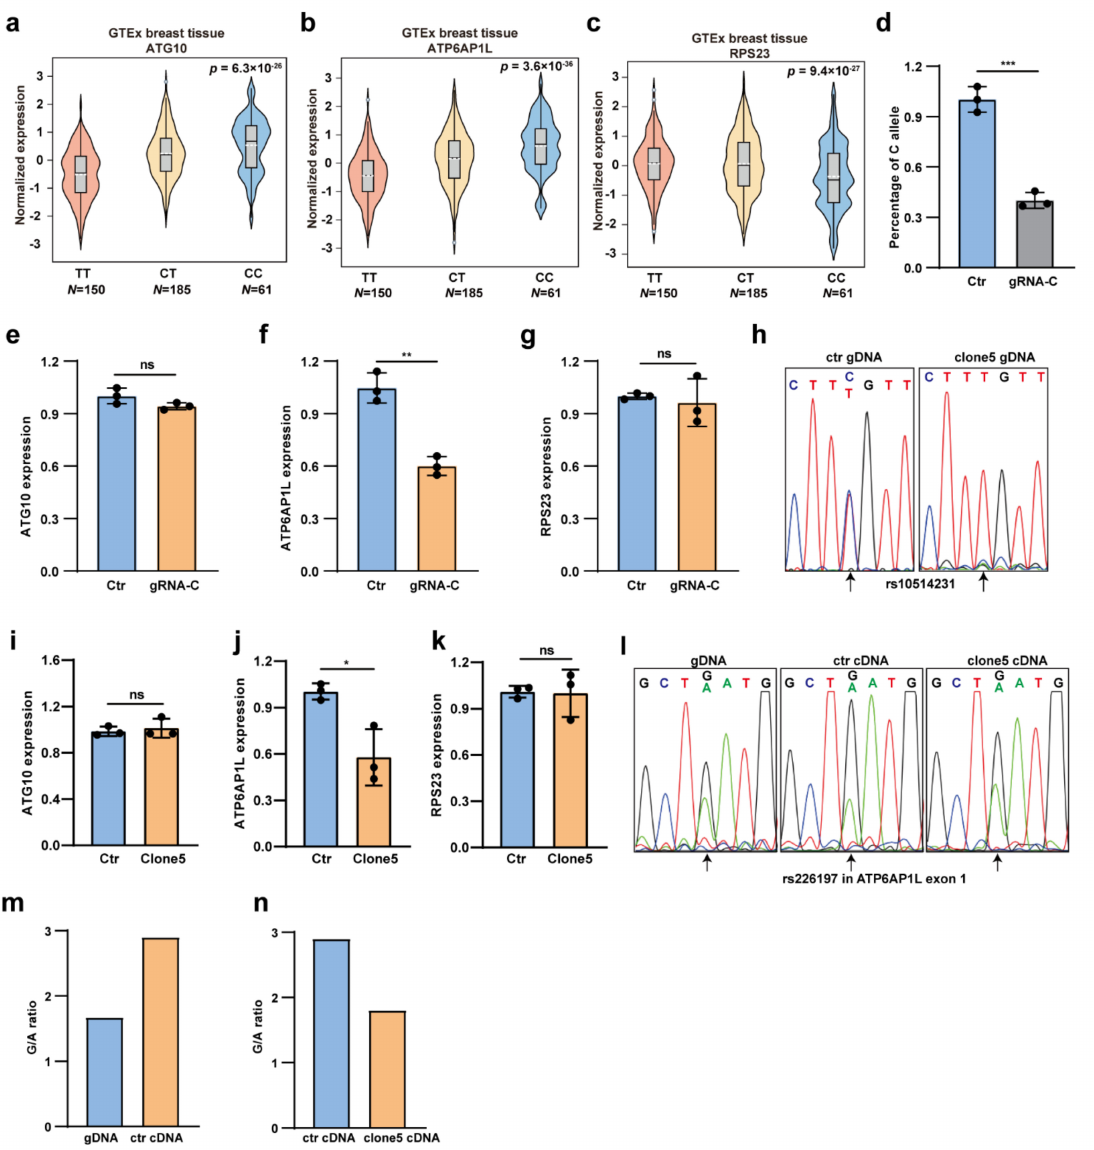
Figure 3. Rs10514231 regulates gene expression of ATP6AP1L . ( a – c ) The eQTL analysis from the GTEx database showing the association between the rs10514231 genotype and expression of ATG10 , ATP6AP1L , and RPS23 in normal breast tissues. ( d ) CRISPR/Cas9-mediated C allele-specific genome editing on the rs10514231 site in MDA-MB-453 cells. The remaining level of the C allele was determined by the getPCR method. Values are the means ± SD; * p < 0.05, two-tailed Student’s t -test. ( e – g ) Gene expression level of the three target genes, ATG10 , ATP6AP1L , and RPS23 , in MDA-MB-453 cells edited with C allele-specific gRNA. Gene expression level determined by RT-qPCR. Values are the means ± SD; ** p < 0.01, ns = not significant, two-tailed Student’s t -test. ( h ) Sanger sequencing chromatogram of the rs10514231 region in clone 5, a T/T genotype MDA-MB-453 cell line, originated from the C allele-specific genome editing. ( i – k ) Gene expression level of the three eQTL genes in the clone 5 cell line, analyzed through RT-qPCR. Values are the means ± SD; * p < 0.05, ns = not significant, two-tailed Student’s t -test. ( l ) Sanger sequencing chromatogram of rs226197 in ATP6AP1L exon 1 in genomic DNA and cDNA of the clone 5 cells and original MDA-MB-453 cells. The altered relative peak height represents the allele-specific expression of the ATP6AP1L gene. ( m , n ) The under-peak area of the G and A allele in the Sanger sequencing chromatogram quantified by EditR 1.0.9 online software (https://moriaritylab.shinyapps.io/editr_v10/, accessed